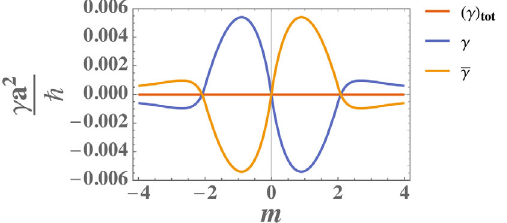
FIG. 6. Anisotropic viscosities plotted with the alternative form of the strain generator. We use the same set of parameters t ¼ 1 . 5 , t ¼ r ¼ 1 , a ¼ 1 as earlier in the work. Curiously, we see that the total anisotropic viscosity is